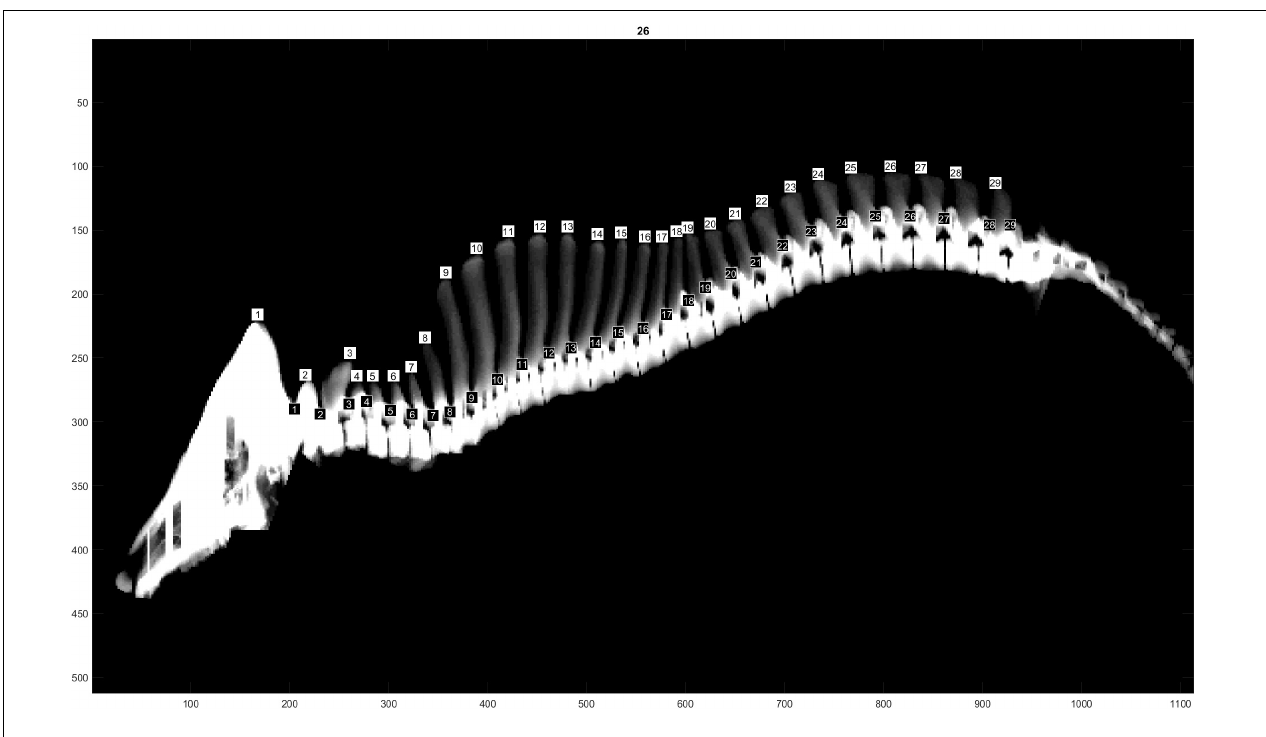
FIGURE 1 | Computer tomography image illustrating the NVE recording.